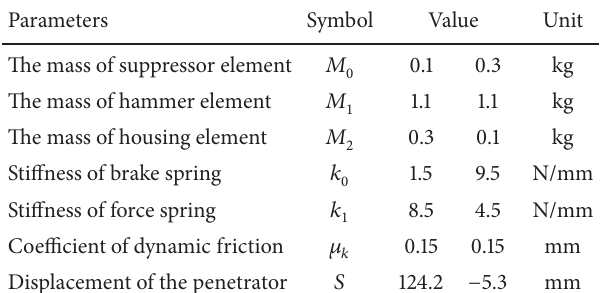
Table 3: Optimal results of structural parameters.